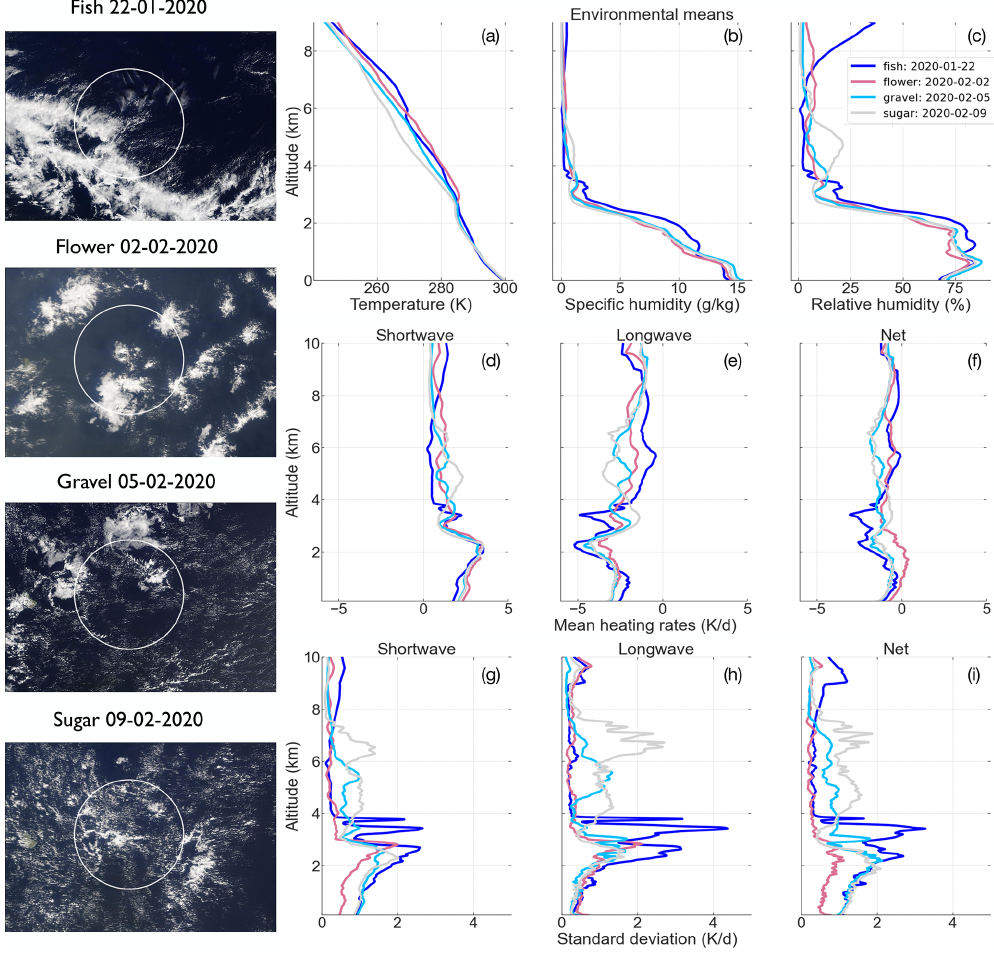
Figure 5. Thermodynamic (a–c) , daily mean radiative heating (d–f) , and daily standard deviation of radiative heating (g–i) profiles classified by mesoscale organization pattern using a characteristic example of each pattern as diagnosed from MODIS-Terra scenes from Worldview (left column). This figure employs HALO dropsondes launched in the circular flight pattern (shown by the white circle) on the chosen day, corresponding to roughly 70 dropsondes each. We focus on the spatial extent of the HALO flight pattern because the cloud organization pattern does not necessarily extend across the entire sampling domain (Fig. 1a), nor have the patterns been shown to be scale